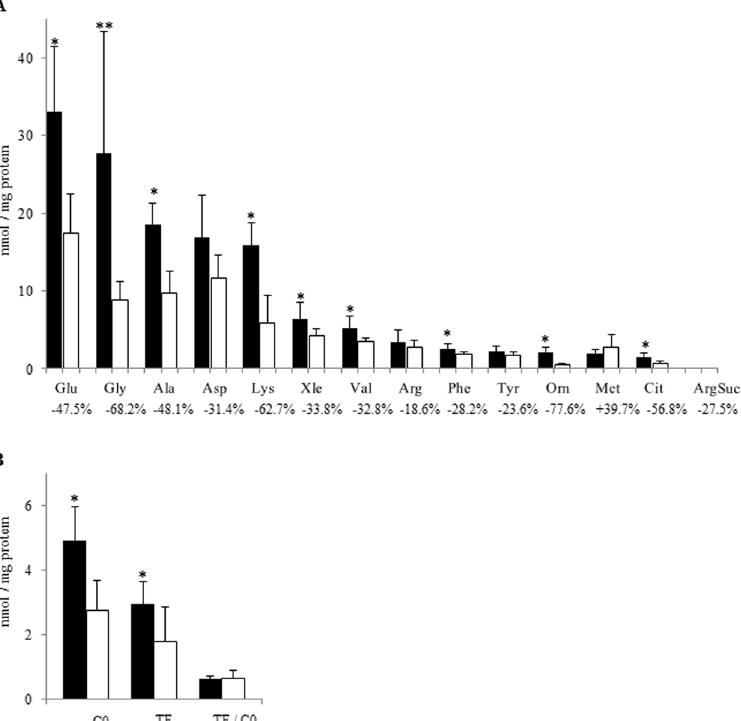
Figure 2. ( A ) Amino acids levels in male (black bars) and female (white bars) hearts. ( B ) C0, TE and TE/ C0 ratio in male (black bars) and female (white bars) hearts. Data are the medians ± MAD of 15 independent samples for each sex. * P < 0.05 and ** P < 0.001, versus females. Percentage of variation in females is reported under amino acid